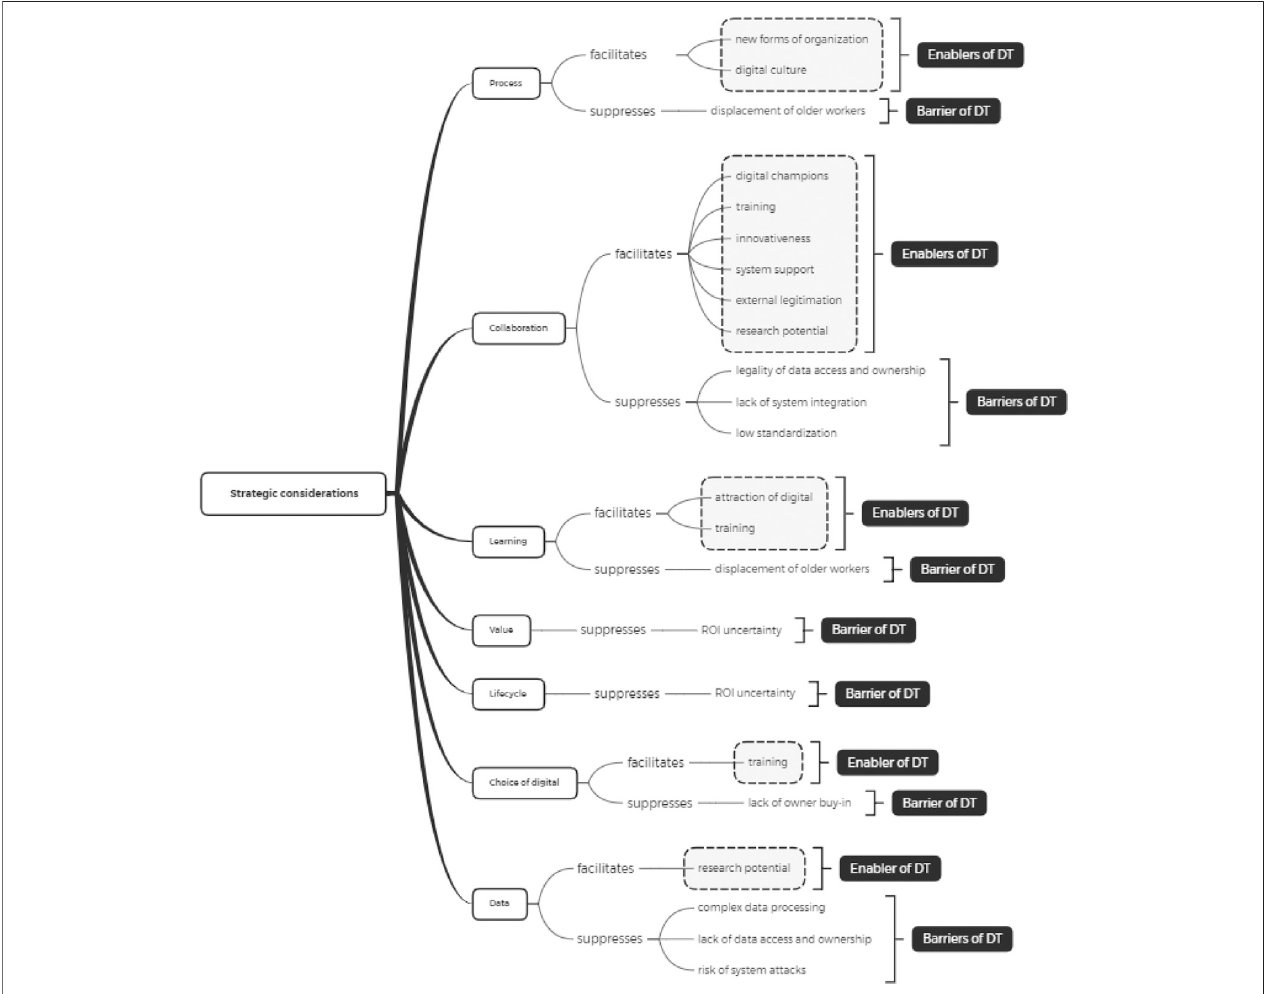
FIGURE 7 | Illustration of DT guideline in